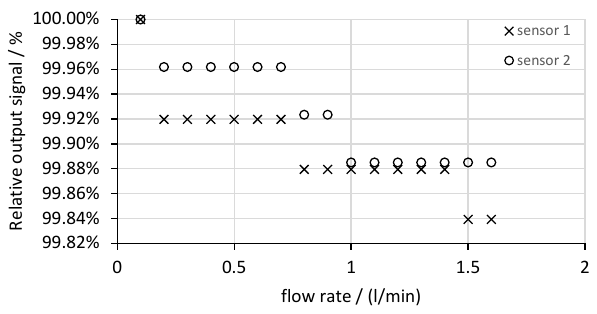
Figure 11. Flow rate dependence of the sensor output voltage for flow velocities up to 1ms − 1 . At the flow rate of 1Lmin − 1 the flow velocity is 0.59ms − 1